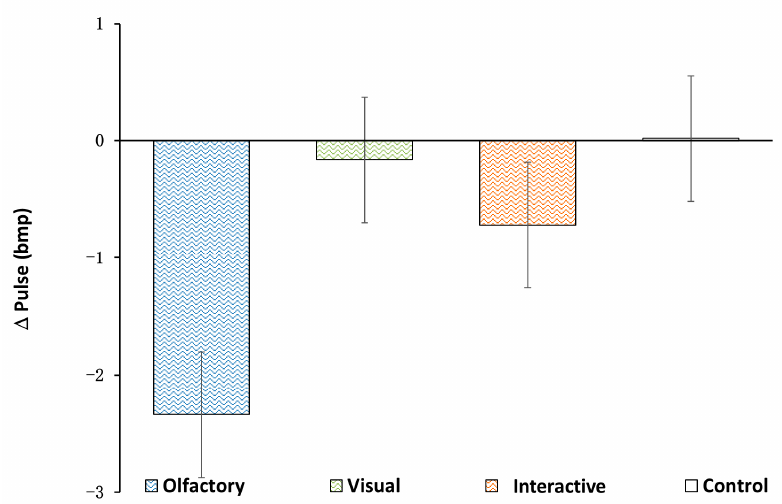
Figure 3. Effects of different stimulation types on human pulse (P).